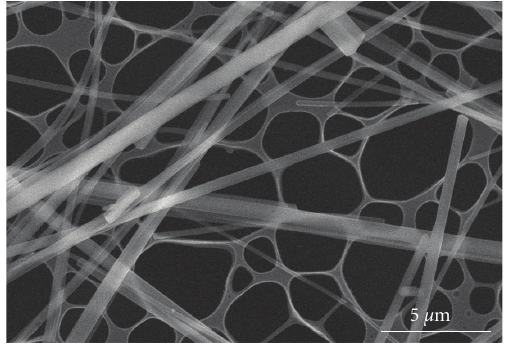
Figure 1: Scanning electron microscopy secondary-electron image of as-precipitated Fe-doped C 60 nanowhiskers. The nanowhiskers are supported on microgrid.